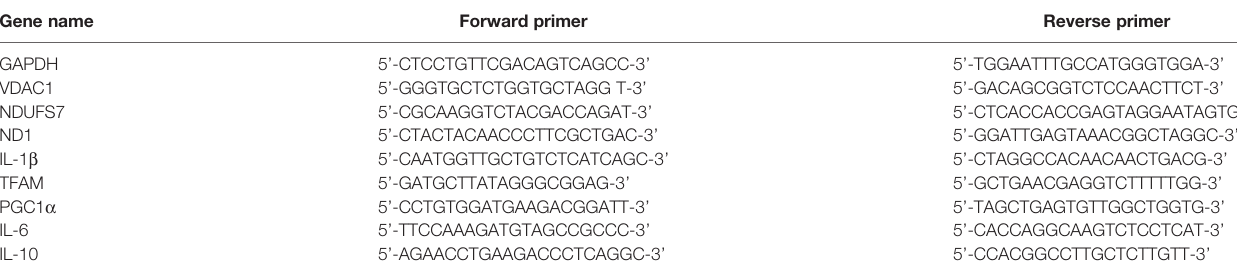
TABLE 1 | List of primers used for real time